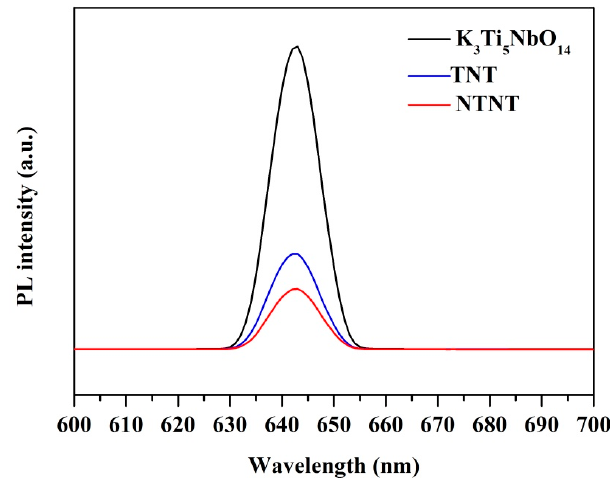
Figure 9. PL spectra of NTNT, TNT, and K 3 Ti 5 NbO 14 .